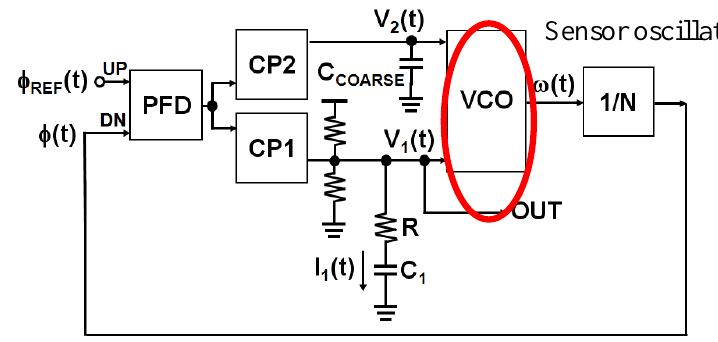
Figure 11. Integration of the frequency shift sensor in a phased lock loop [56].